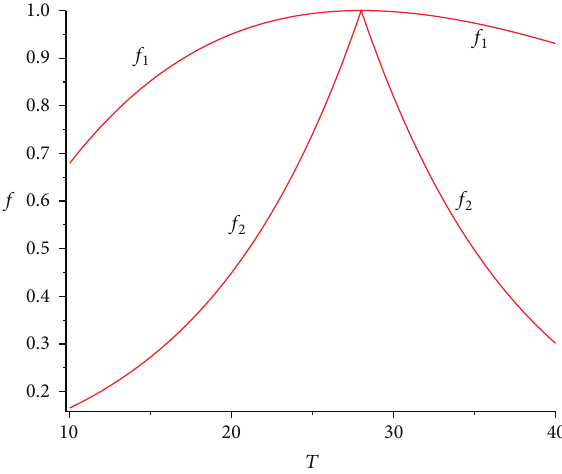
Figure 2: 𝑓 1 (𝑇) = (𝑇/28)𝑒 1−(𝑇/28) , 𝑓 2 (𝑇) = 𝑒 −(2.3/23)|𝑇−28|